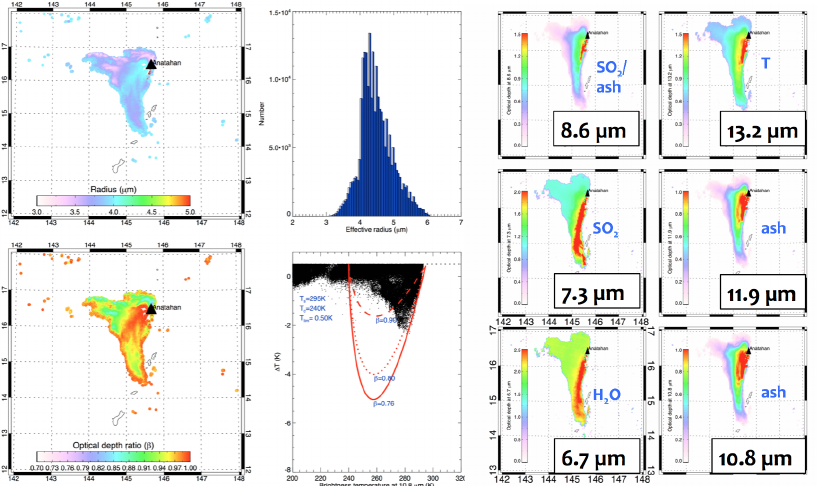
Figure 8. Illustration of the information content in each of the IR MODIS channels for a volcanic cloud from the eruption of Anatahan volcano, Northern Mariana Islands in July